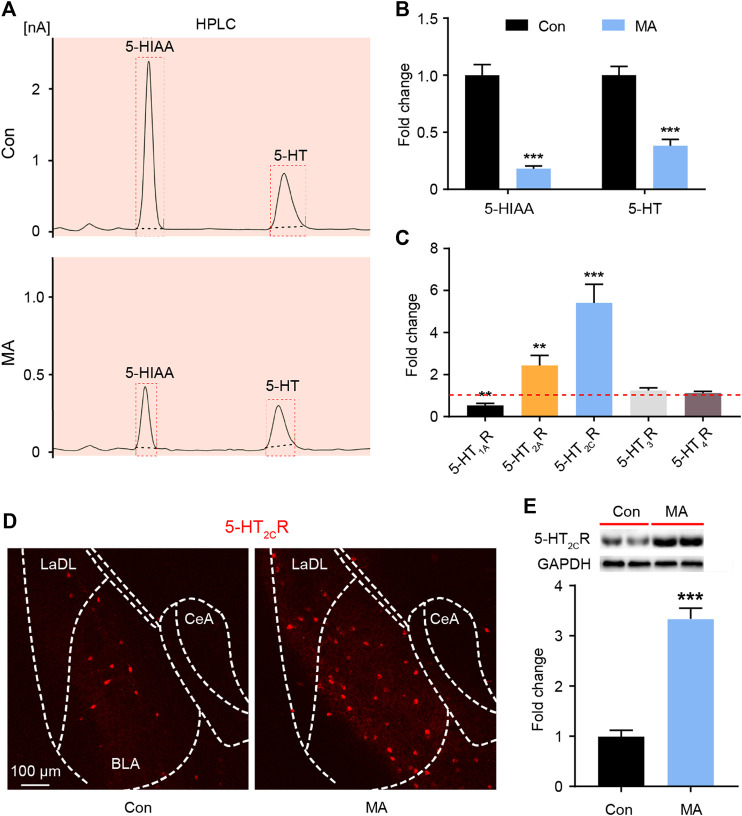
Effects ofchronic MA administration on serotonergic changes in BLA. (A) HPLC results of 5-HIAA and 5-HT in BLA. (B) Relative concentrations of 5-HIAA and 5-HT in BLA. (C) Relative mRNA expression of 5-HT1AR, 5-HT2AR, 5-HT2CR, 5-HT3R, and 5-HT4R in BLA. (D) 2C immunoreactivity in BLA of the mice brain, scale bar = 100 μm. (E) 5-HT2CR expression was quantified by WB. 5-HIAA; 5-hydroxyindole acetic acid. Data are presented as the mean ± SEM. **p < 0.01, ***p < 0.001.